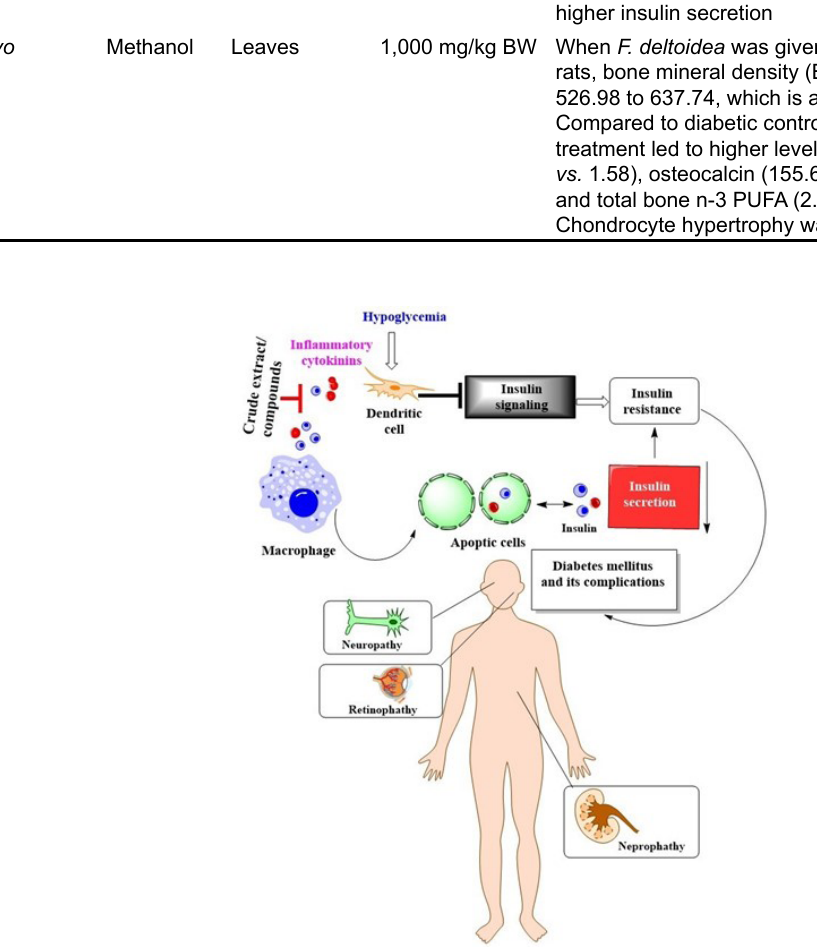
Figure 5. Mechanism of action of F. deltoidea against hypoglycemia Antihypertensive